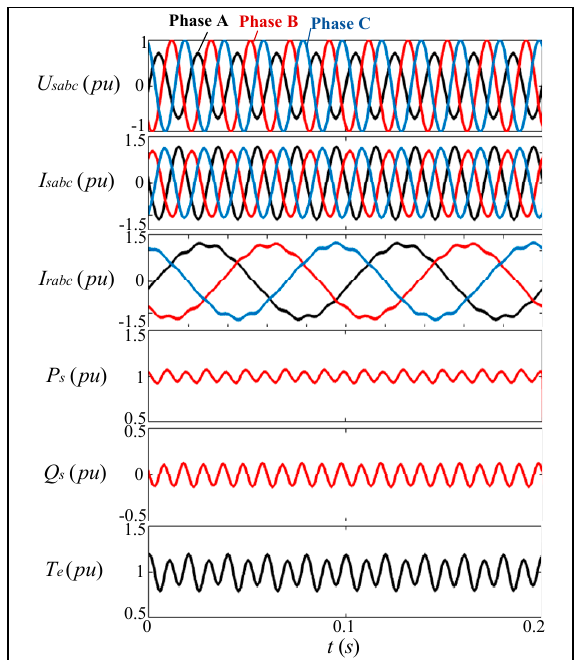
Figure 6. Conventional VSG control under a single-phase grid voltage drop of 30%.